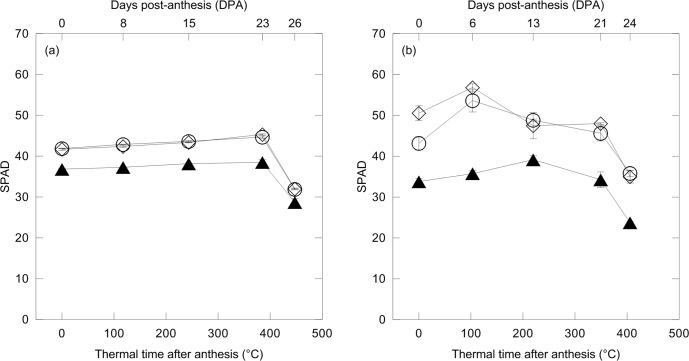
Changes of soil-plant analysis development (SPAD) against thermal time after anthesis (cumulative average daily air temperature exceeding 0°C, °C d) and days post-anthesis (DPA) (above axis) of durum wheat in 2011 (a) and 2012 (b). Wheat plants were exposed to control conditions (unfertilized CONTROL, black triangle) and to N fertilization treatments with urea (UREA, white rhombus) and calcium nitrate (NITRATE, white circle) at the rate of 150 kg N ha-1 (mean value ± standard errors, n = 3 independent replicates; split-plot ANOVA over thermal time after anthesis; effects: (a) treatment, P < 0.01; time, P < 0.01; treatment x time, P < 0.05; (b) treatment, P < 0.01; time, P < 0.01; treatment x time, P< 0.01).